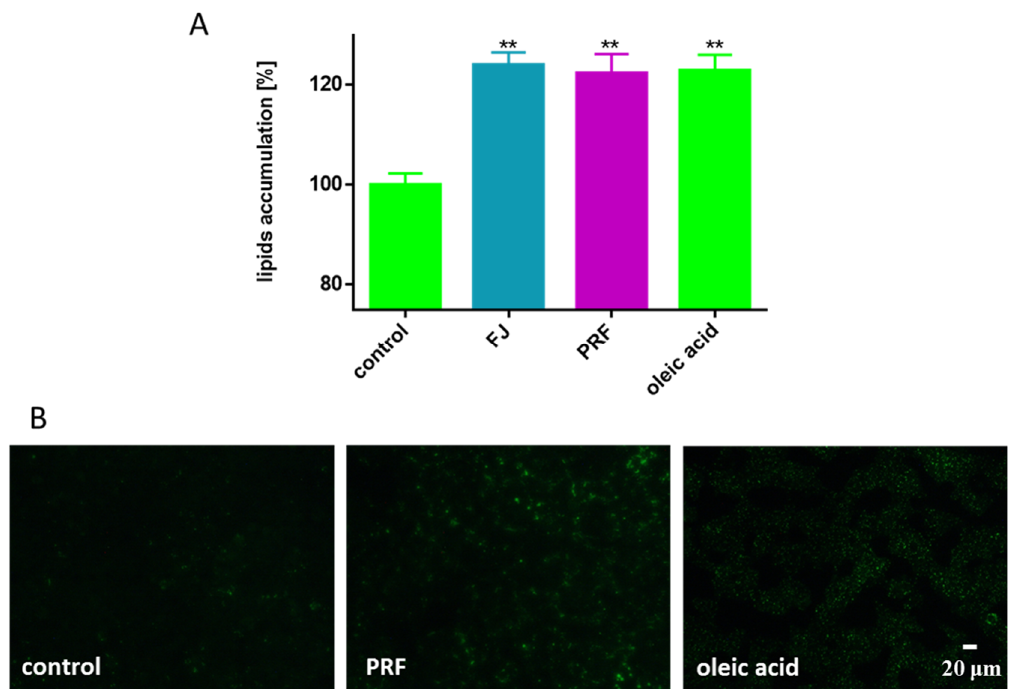
Figure 7. The influence V. opulus extracts on the accumulation of lipid droplets in MIN6 cells stained with Nile red observed after treating cells with the extracts at IC 0 for 24 h ( A ); as a positive control, 100 µM oleic acid was used; control cells were not exposed to any compound but the vehicle; values are means ± standard deviations from at least three independent experiments, n ≥ 12; statistical significance was calculated versus control cells ** p ≤ 0.01. Cells visualized under fluorescent microscope (200 × magnification) ( B ).